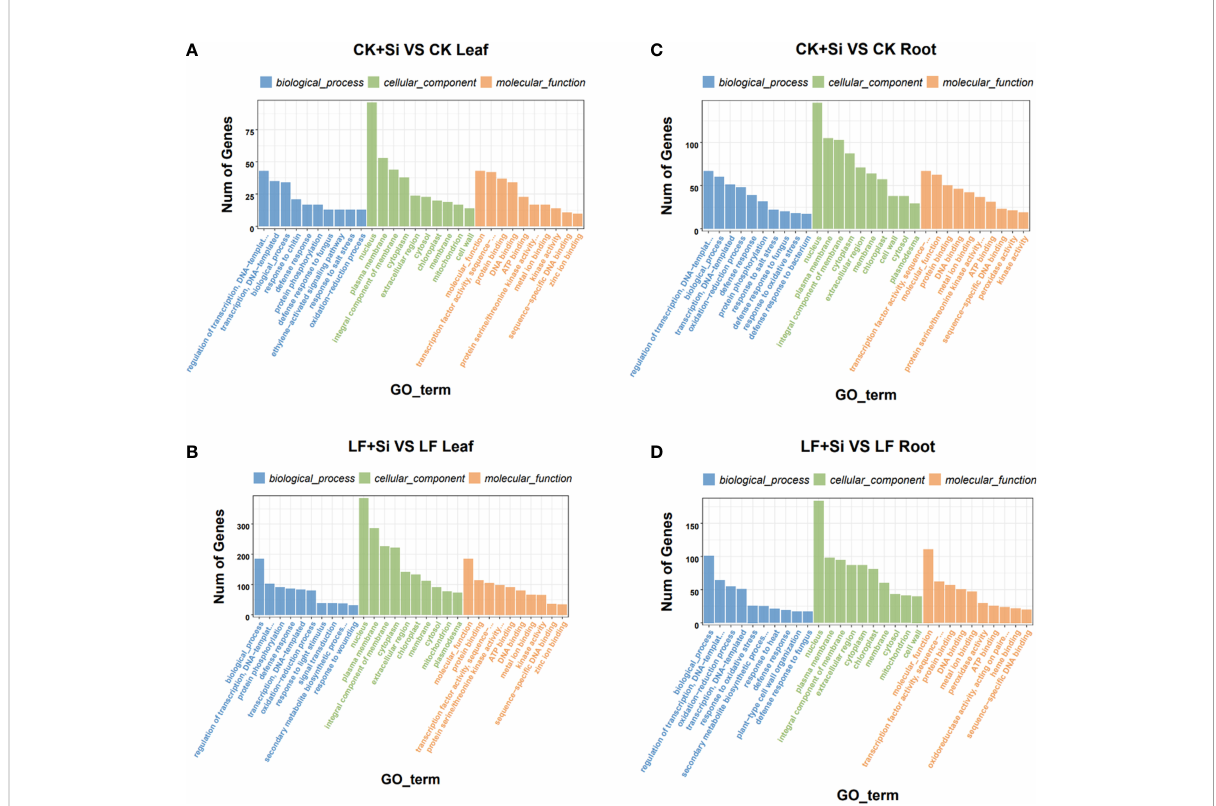
FIGURE 3 The GO enrichment analysis of differentially expressed genes. (A, B) The GO enrichment analysis in leaves. (C, D) The GO enrichment analysis in